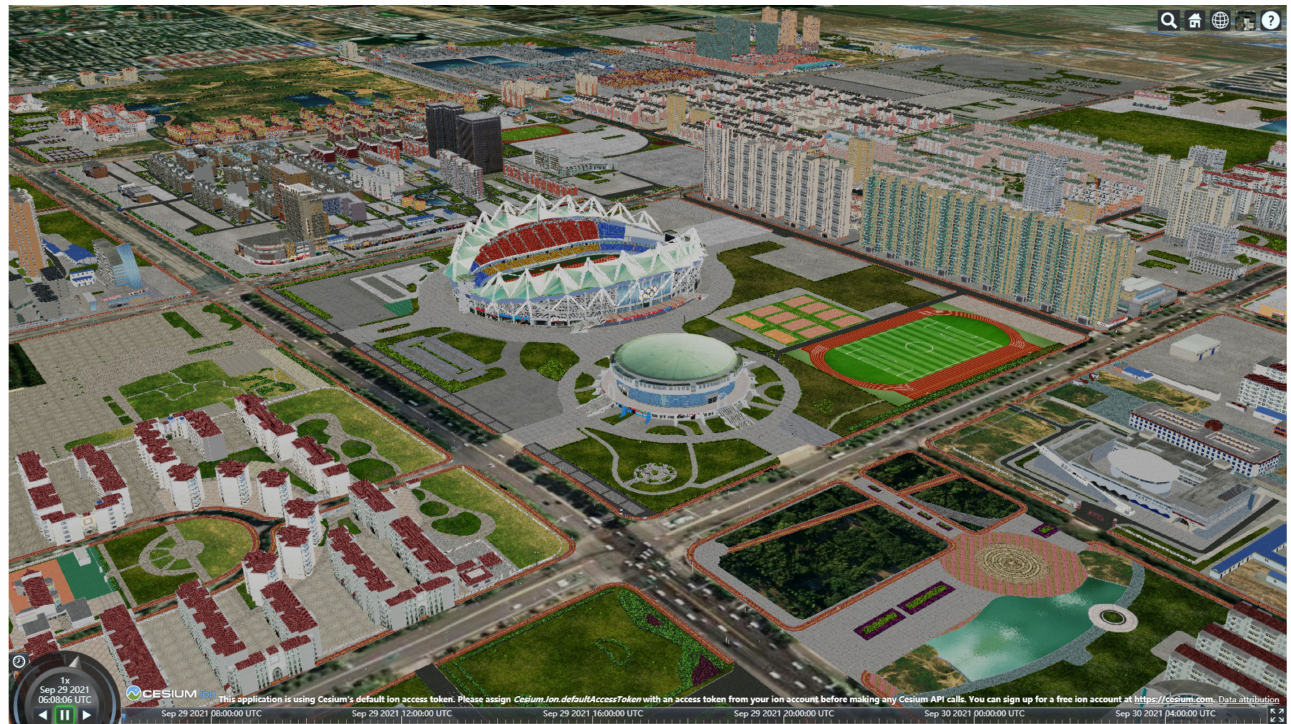
Figure 13. Large-scale building model